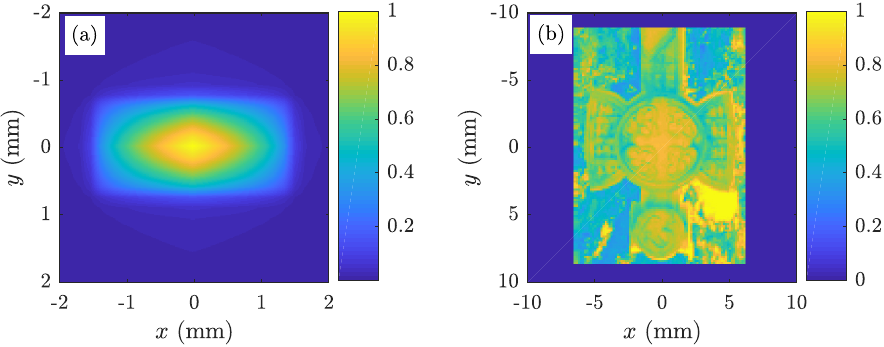
Figure 2. Spatial filter T images: ( a ) spatial coherence control simulation (Section 3.1); and ( b ) beam shaping simulation (Section